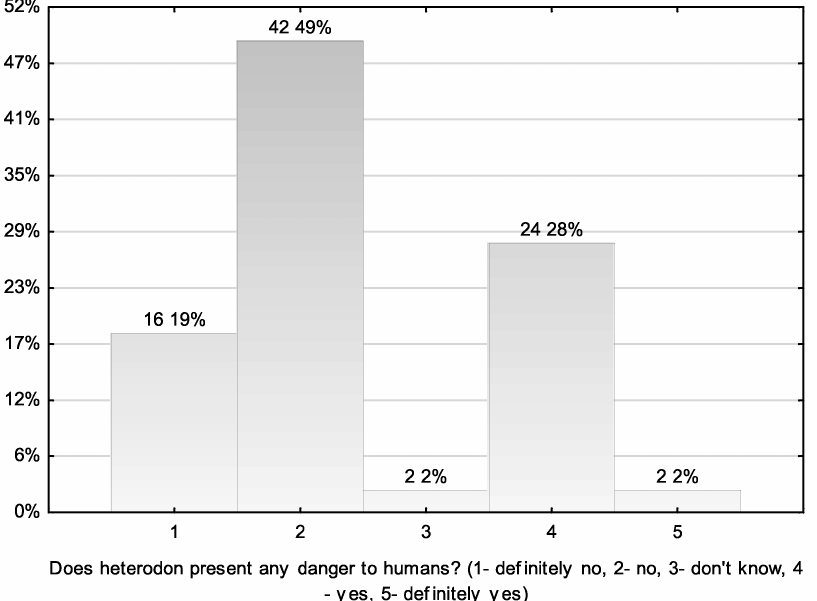
Figure 2. Respondents’ answers to the question of a potential threat posed by Heterodon snakes to humans ( n ; %).